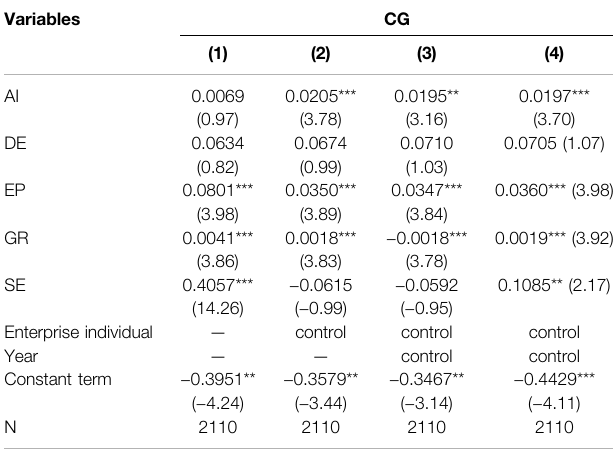
TABLE 5 | Regression analysis of the application of arti fi cial intelligence and corporate governance